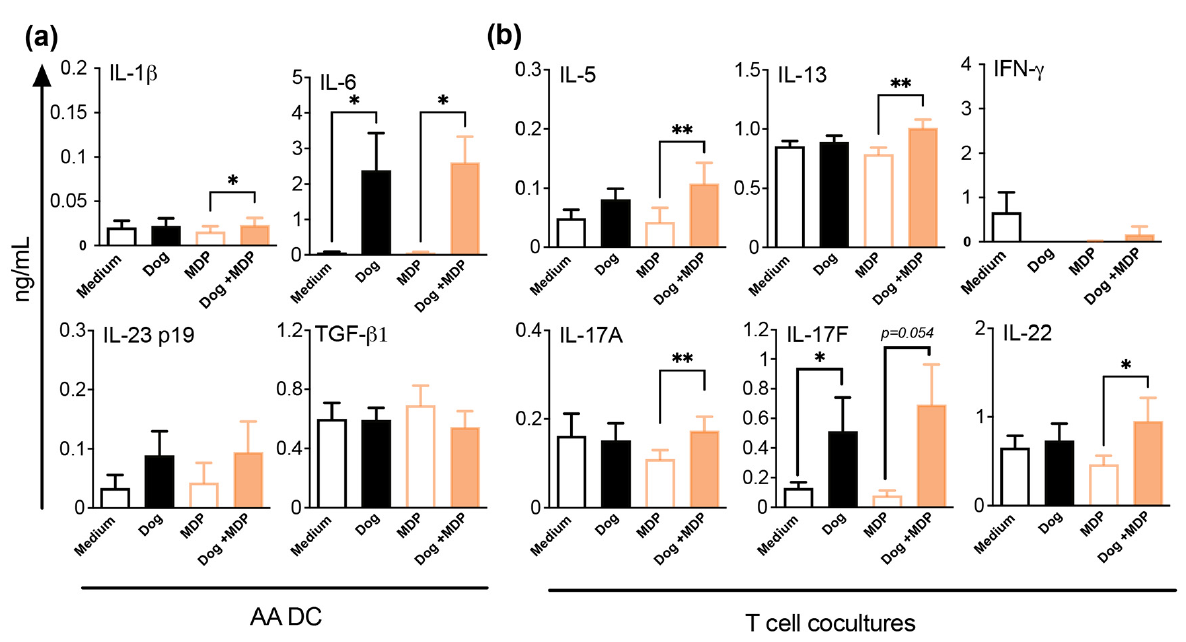
Figure 8. MDP co-stimulation of DC from AA subjects promotes DC cytokine production and Th2/Th17 cell polarization. ( a ) Cytokine profile of DC supernatants quantified by ELISA. ( b ) Cytokine profile of DC/T cell supernatants evaluated after 5 days of co-culture by ELISA. Data are presented as mean ng/mL ± SEM for n = 10 AA. * p < 0.05 versus medium or MDP, ** p < 0.01 versus MDP. Friedman test for all.